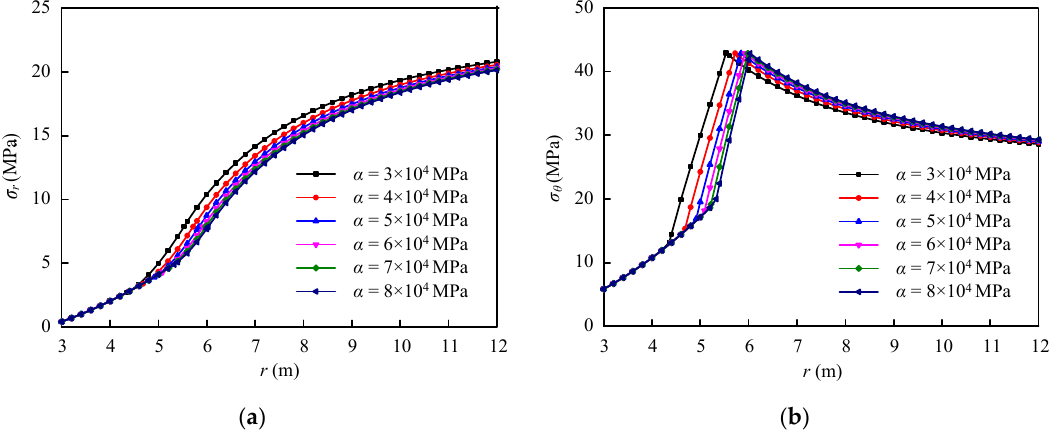
Figure 10. Effect of softening modulus coefficient of cohesion on the stress distribution in the tunnel surrounding rock. ( a ) σ r ; ( b ) σ θ .